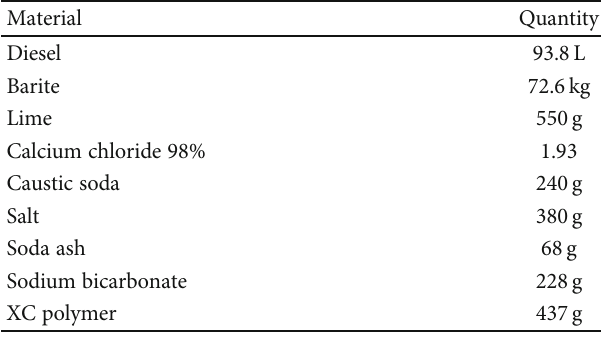
Table 6: OBM composition (one barrel).